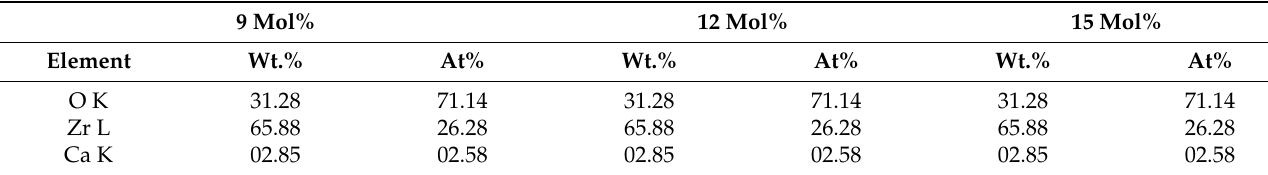
Table 1. EDS analysis of all three compositions.